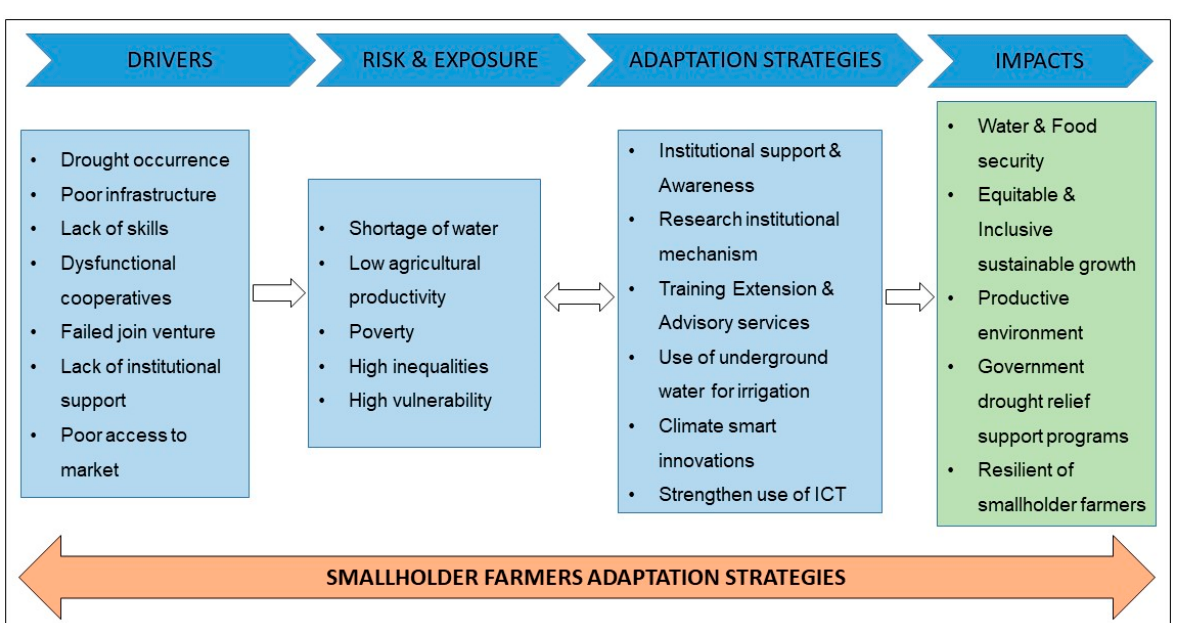
Figure 4. Policy-relevant adaptation strategies for forming coherent